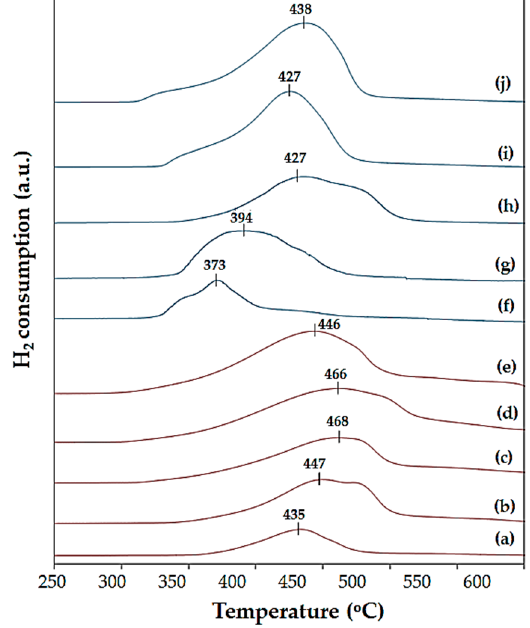
Figure 4. H 2 -TPR profiles of the Ni/SB and Ni/SF catalysts at various Ni contents: ( a ) 10 wt% Ni/SB, ( b ) 20 ( b ) 20 wt% Ni / SB, ( c ) 30 wt% Ni / SB, ( d ) 40 wt% Ni / SB, ( e ) 50 wt% Ni / SB, ( f ) 10 wt% Ni / SF, ( g ) 20 wt% wt% Ni/SB, ( c ) 30 wt% Ni/SB, ( d ) 40 wt% Ni/SB, ( e ) 50 wt% Ni/SB, ( f ) 10 wt% Ni/SF, ( g ) 20 wt% Ni/SF, ( h ) 30 Ni / SF, ( h ) 30 wt% Ni / SF, ( i ) 40 wt% Ni / SF and ( j ) 50 wt% Ni / wt% Ni/SF, ( i ) 40 wt% Ni/SF and ( j ) 50 wt% Ni/SF.